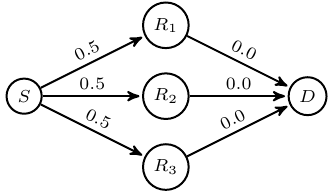
Figure 1: Simple Network